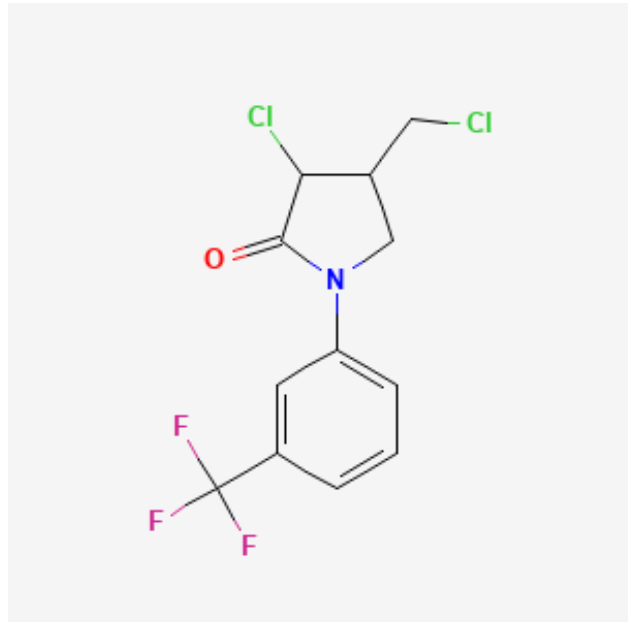
Figure 3. Chemical structure of flurochloridone [19].